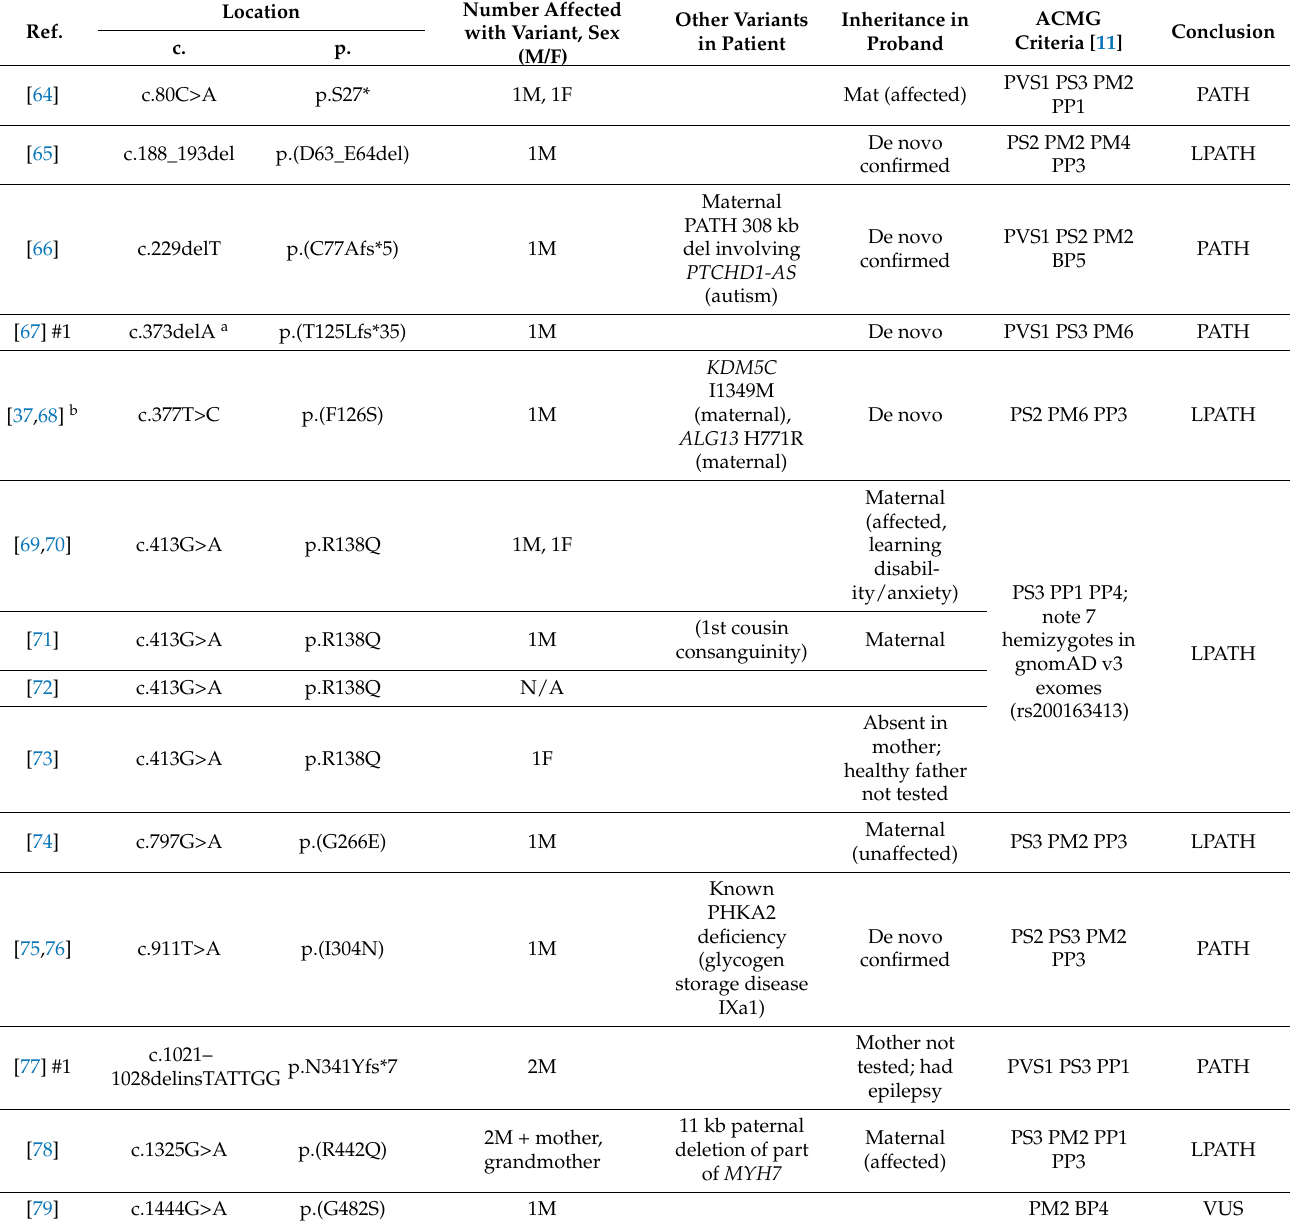
Location Number Affected